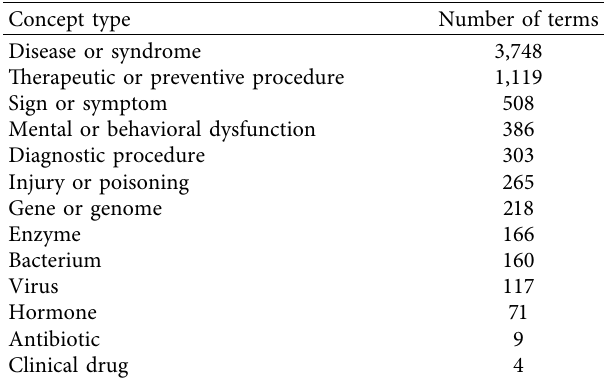
Table 2: The number of terms for each concept type in the an- notated English-Arabic medical